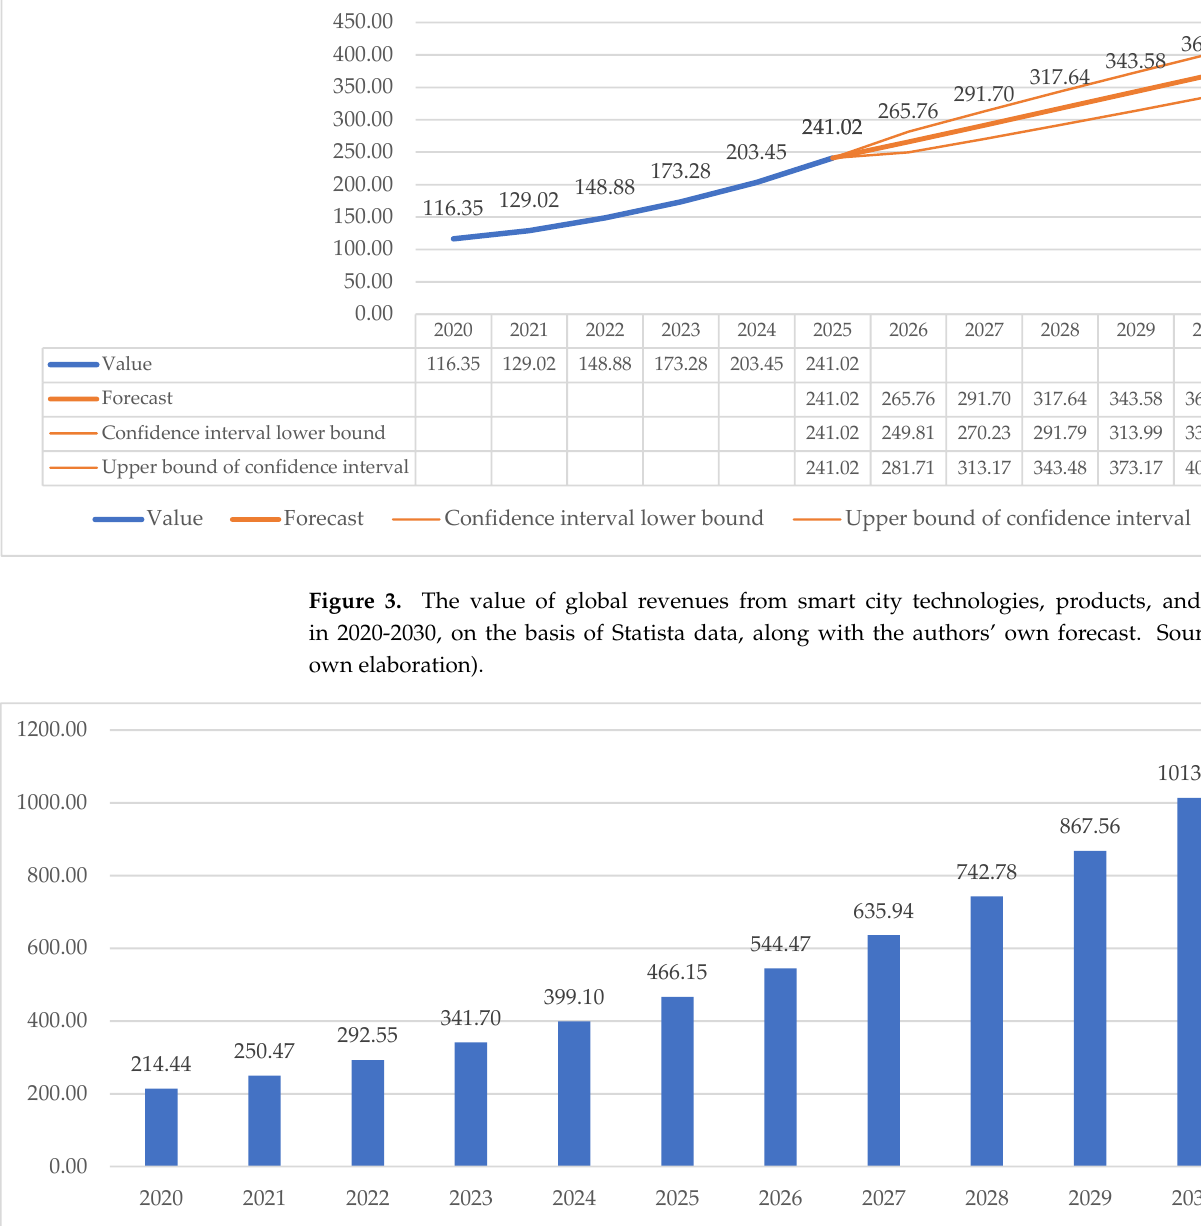
Figure 4. The value of the European market of smart city solutions and technologies in 2020-2030 on the basis of Allied Market Research data, along with the authors’ own forecast. Source: ([84], own elaboration).